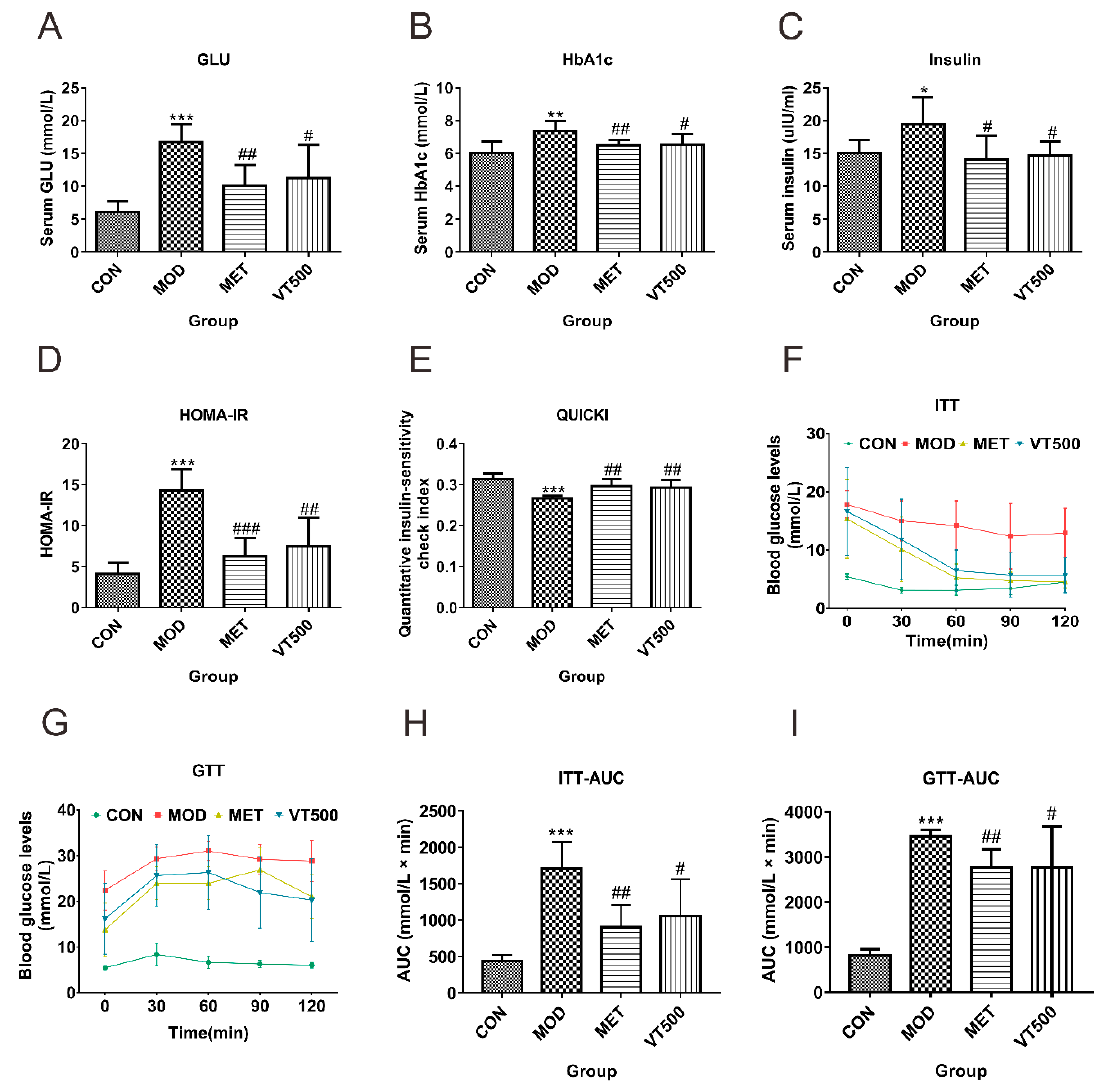
Figure 2. Effect of VT on serum glucose (GLU), glycated hemoglobin A1c (HbA1c), insulin, glucose tolerance and insulin sensitivity in rats with T2D. Fasting serum glucose ( A ), HbA1c ( B ), and insulin ( C ) were measured at the end of 4 weeks of treatment with VT, and the homeostasis model assessment of insulin resistance (HOMA-IR, D ) index and the quantitative insulin sensitivity check index (QUICKI, E ) were calculated. Blood was collected from the tail vein, and glucose levels were determined 0, 30, 60, 90, and 120 min after either insulin administration in the insulin tolerance test (ITT, F ) or 50% glucose administration in the glucose tolerance test (GTT, G ). The insulin area under the curve (AUC, H ) and glucose AUC ( I ) was calculated. The data shown as the mean ± SD. * p < 0.05, ** p < 0.01, *** p < 0.001 compared with the CON group; # p < 0.05, ## p < 0.01, ### p < 0.001 compared with the MOD group, n = 6.